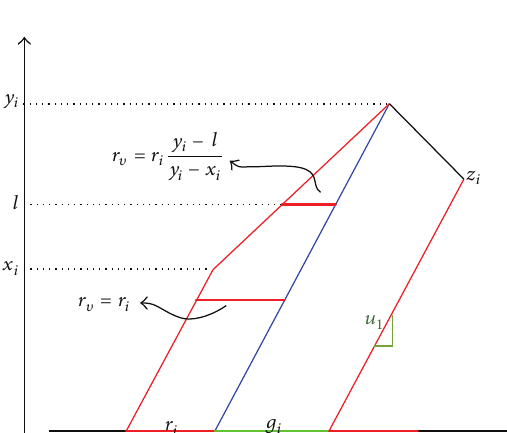
Figure 8: Initial oversaturated queue.